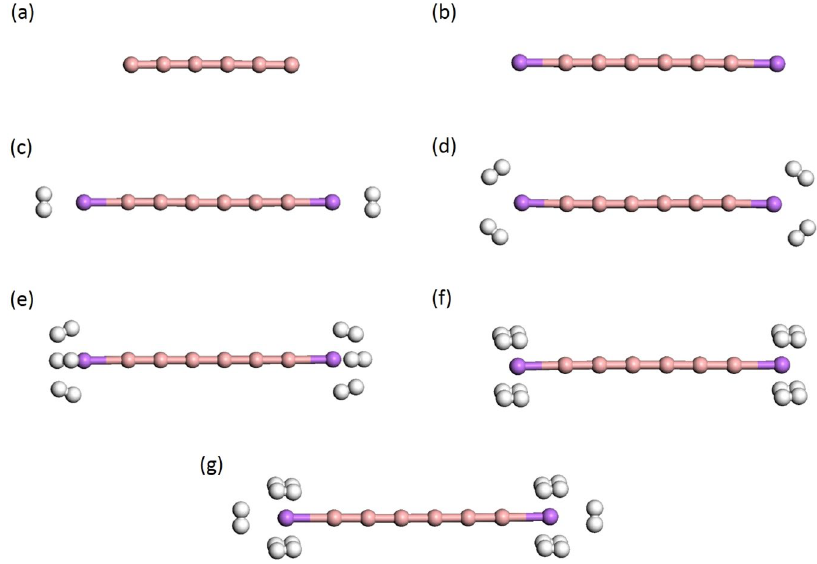
Figure 1. Structures of ( a ) linear boron chain (B 6 ), ( b ) Li-terminated linear boron chain (Li 2 B 6 ), and ( c – g ) Li 2 B 6 with x H 2 molecules ( x = 1–5) adsorbed on each Li, obtained with TAO-BLYP-D. Here, pink, purple, and white balls represent B, Li, and H atoms, respectively. For the longer Li 2 B n ( n = 8, 10, … , and 16), the H 2 adsorption patterns remain